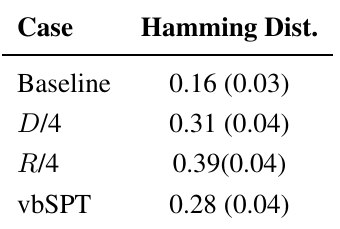
Table 1. Effects of misspecifying “Base Measure” parameters. The average Hamming distance (a number between 0 and 1, with 0 indicating a perfect match) measured over 500 trajectories each of length 1000 (empirical standard errors indicated in parenthesis). The cases in the leftmost column are described in the text.